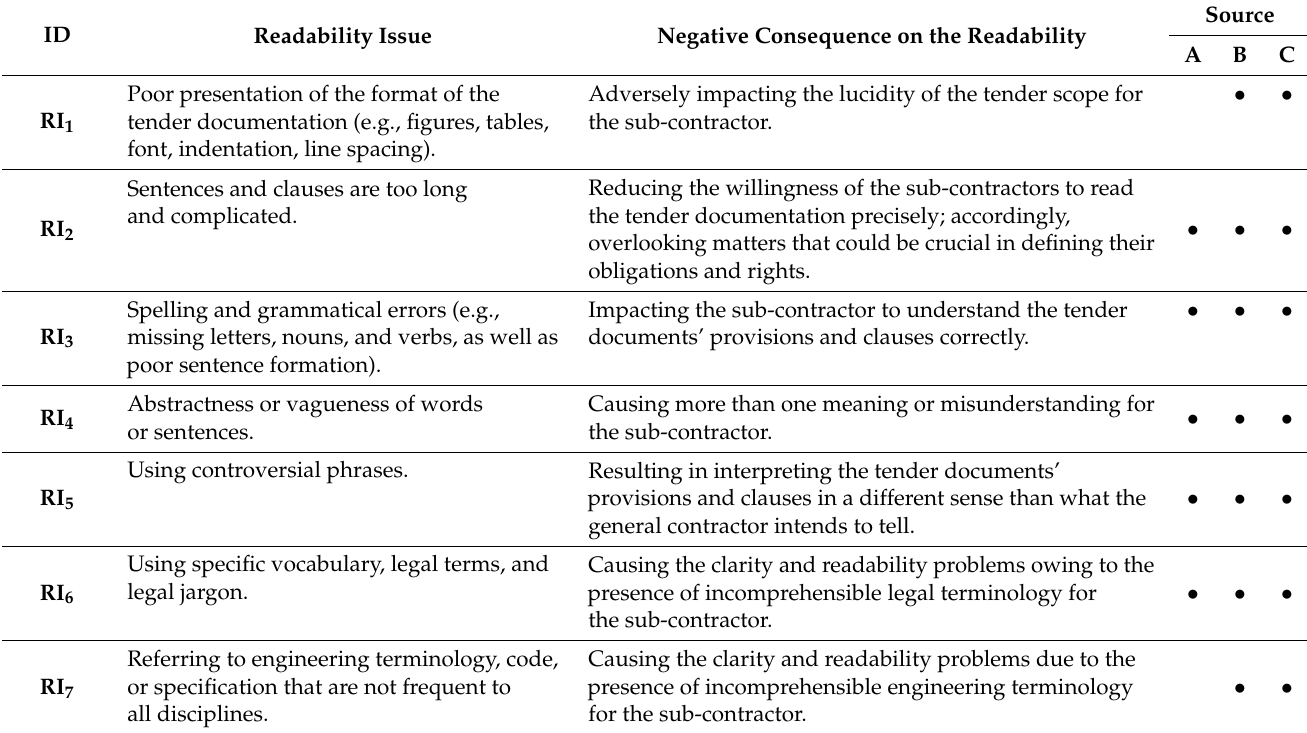
Table 2. Readability issues in the tender